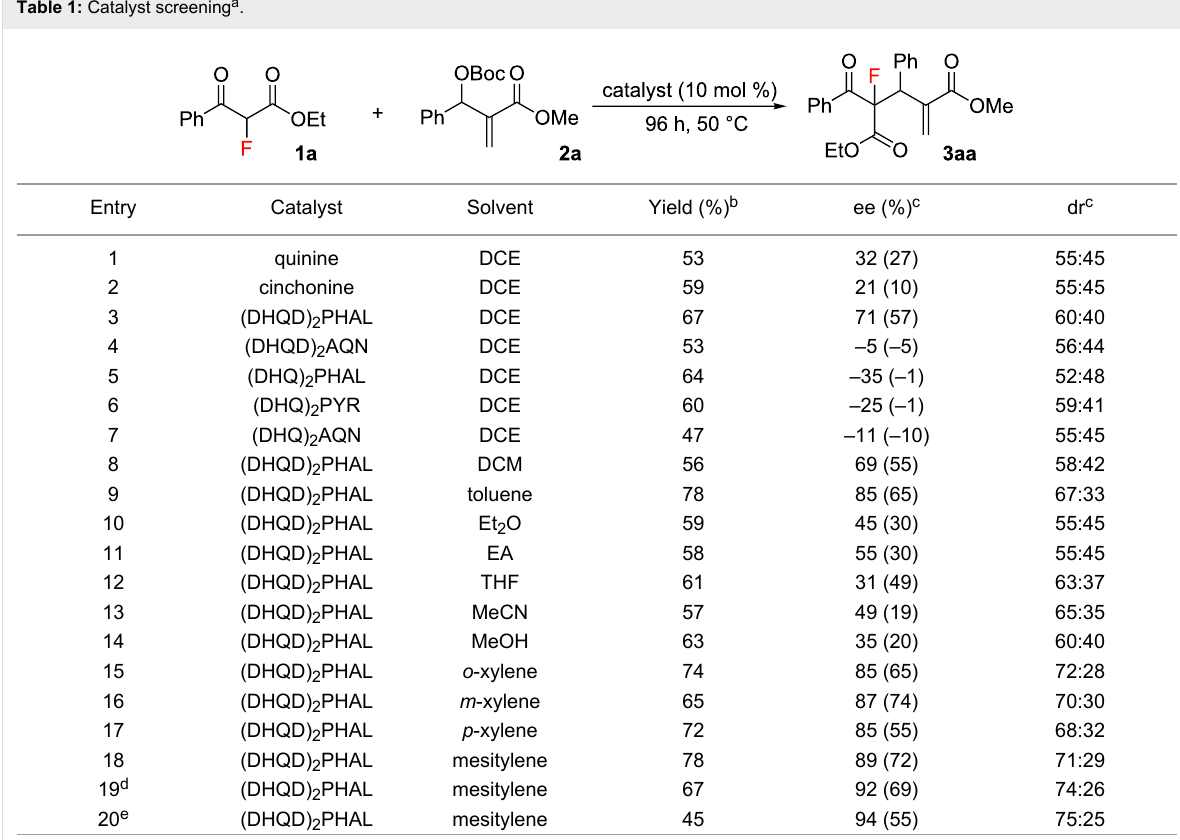
Table 1: Catalyst screening a